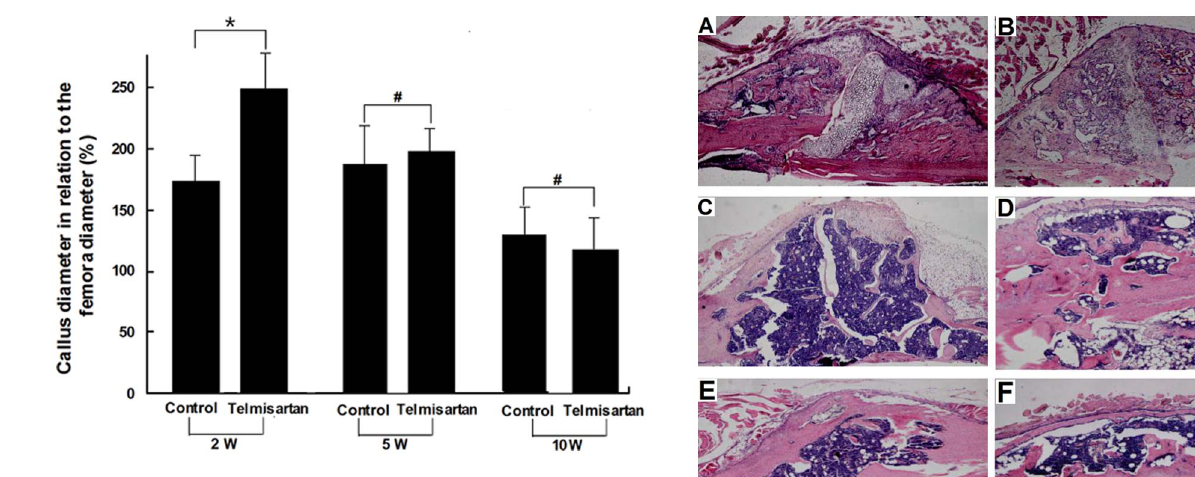
2 weeks 5 weeks 10 weeks Control Telmisartan P Control Telmisartan P Control Telmisartan P